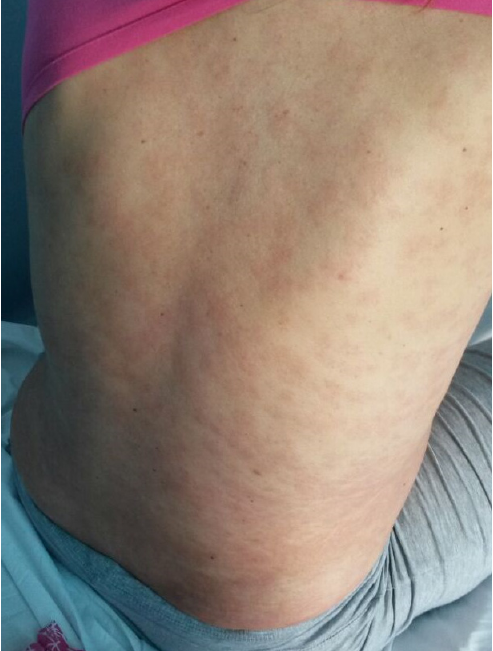
Figure 5. Residual erythematous patches after systemic corticosteroid